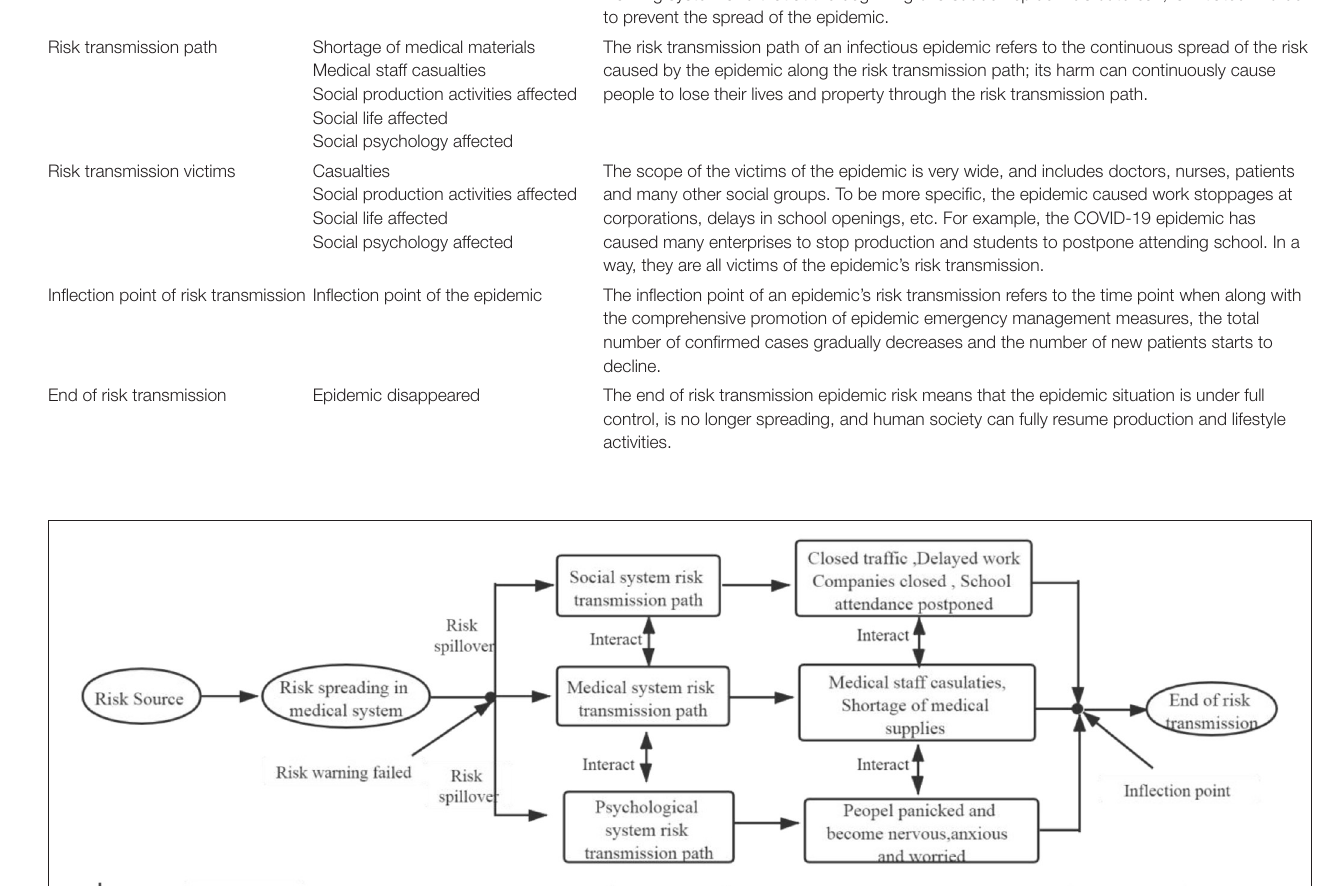
unknown; only the genome of the virus has been